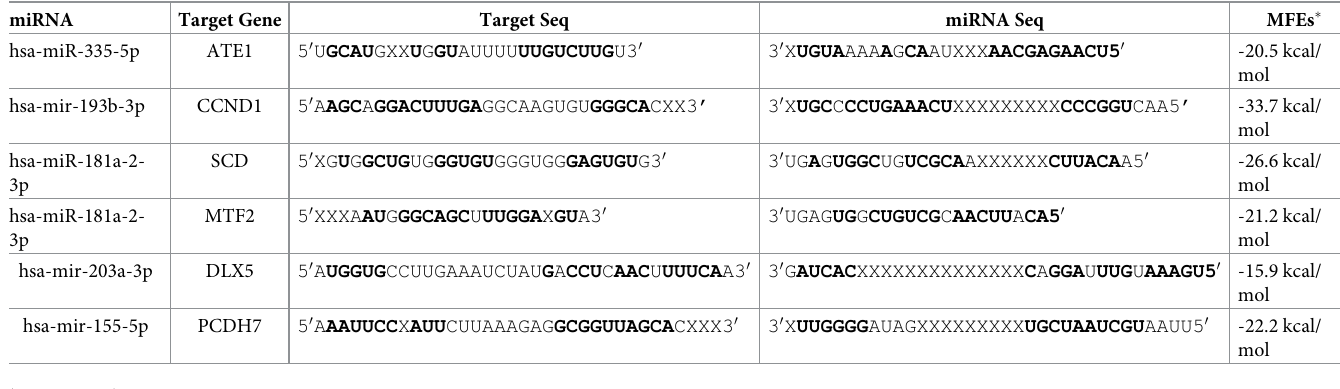
Table 3. The miRNA and target gene binding locations and their binding scores.